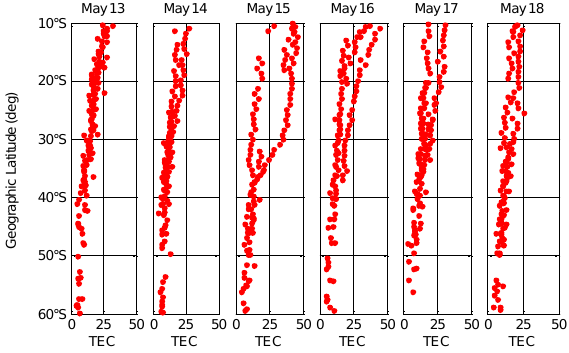
Figure 9 Changes in the VTEC data obtained by the Jason-1 satellite in the descending orbit from 13 to 18 May. Fig. 9. Changes in the VTEC data obtained by the Jason-1 satellite